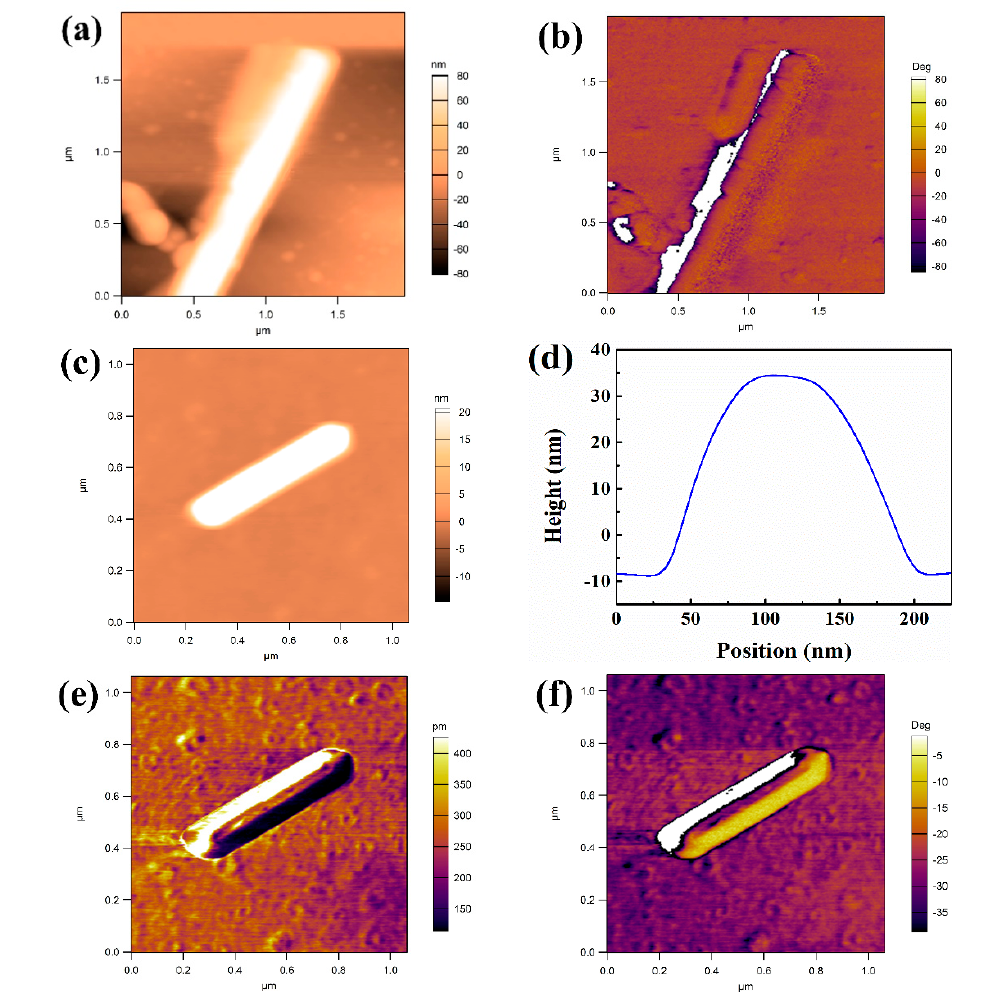
Figure 2. The topographies ( a , c ), phase ( b , f ), profile ( d ) and amplitude ( e ) images of two BFO nanowires (NWs).